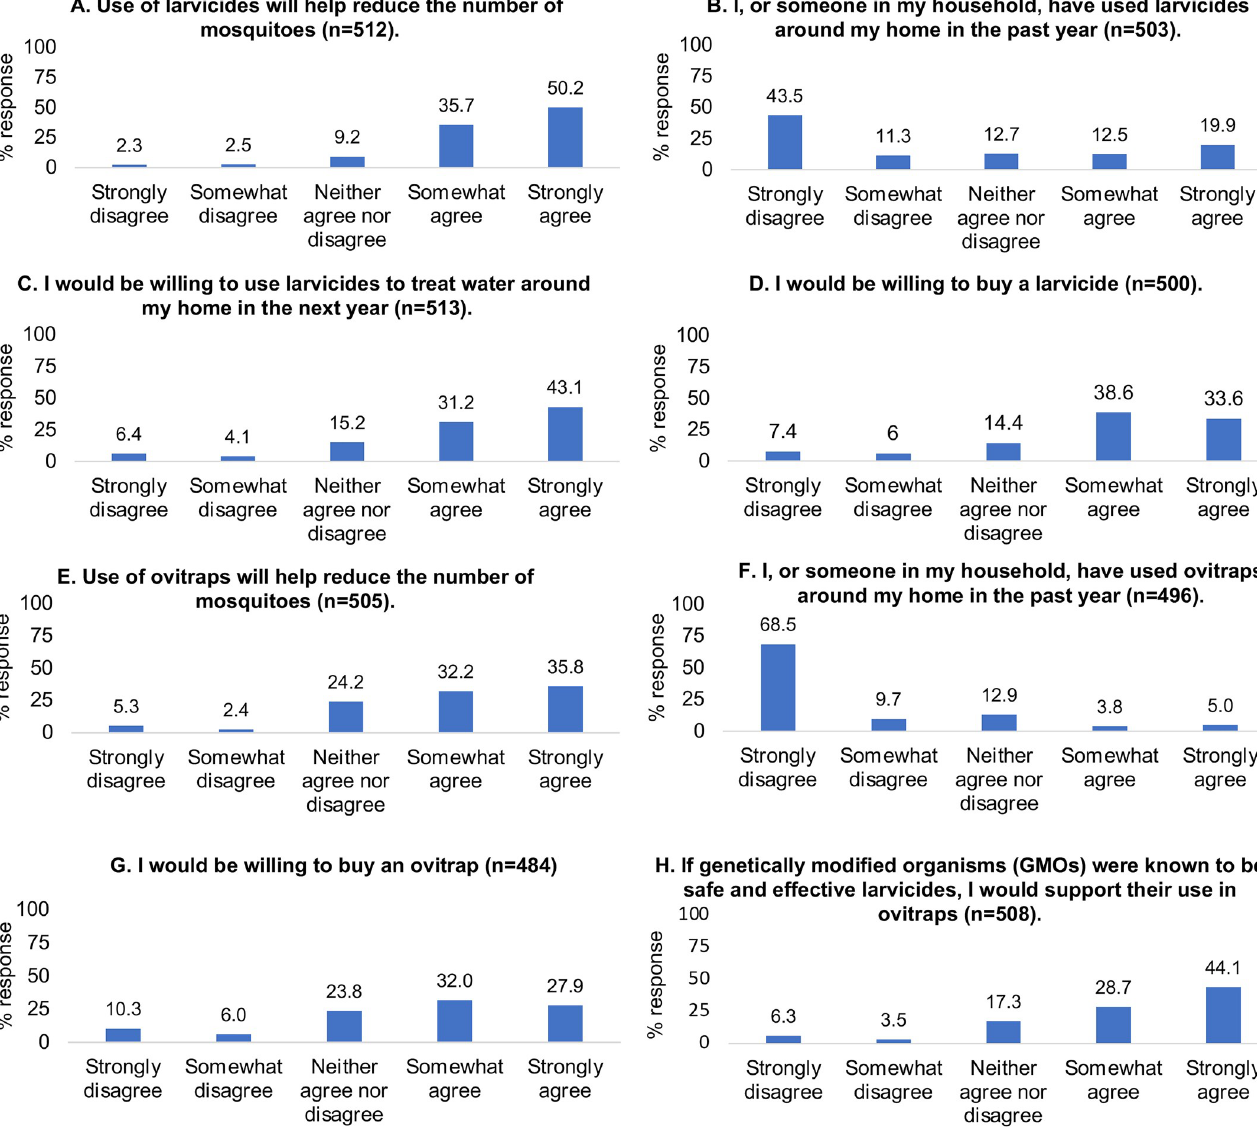
PLOS ONE | https://doi.org/10.1371/journal.pone.0252997 June 29,